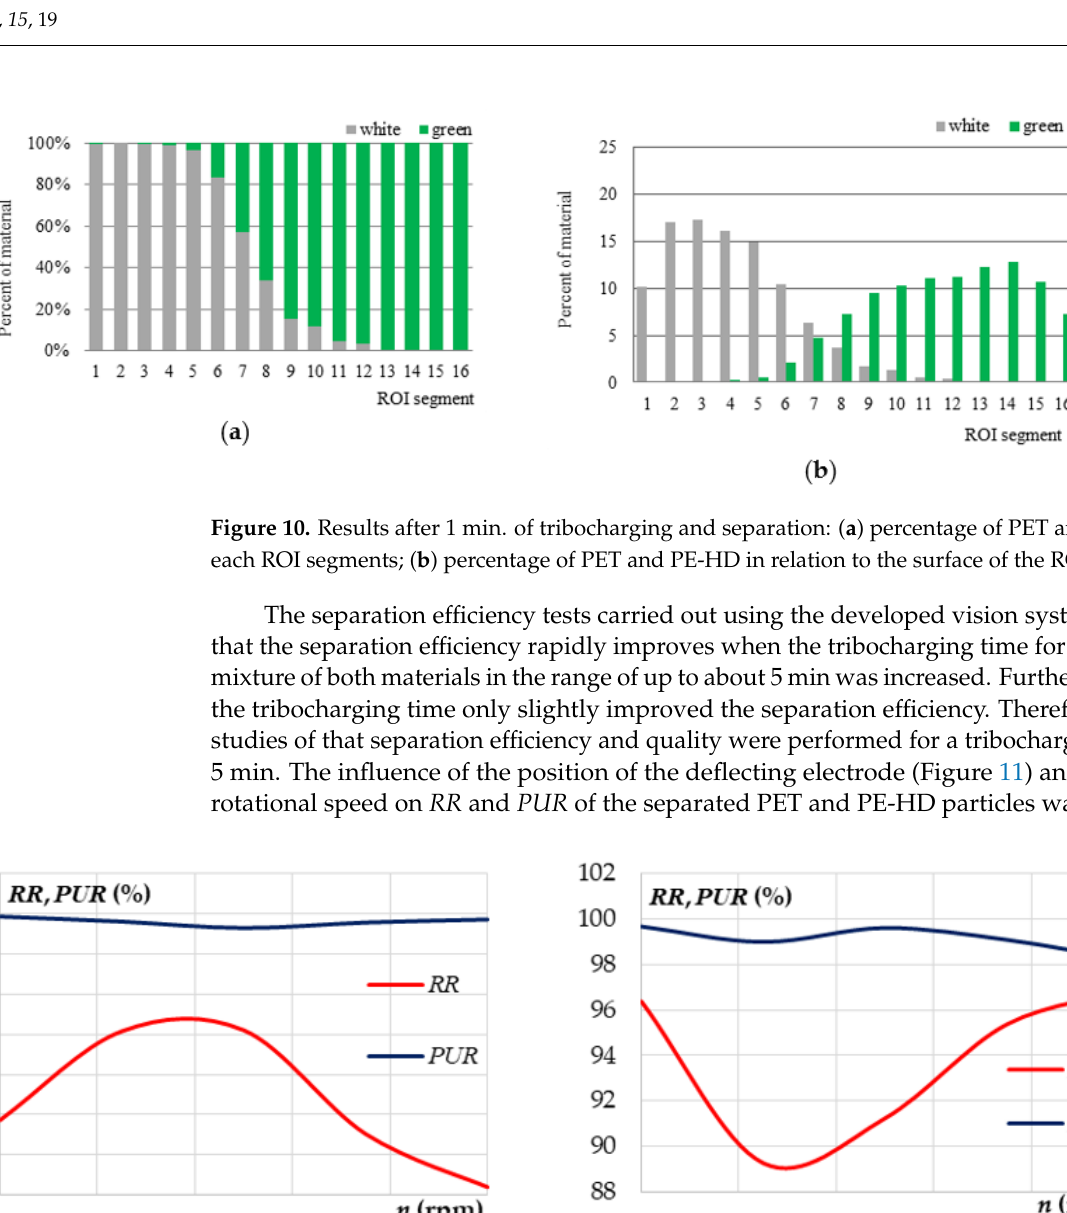
Figure 9. Results after 5 min. of tribocharging and separation: ( a ) percentage of PET and PE-HD in each ROI segments; ( b ) percentage of PET and PE-HD in relation to the surface of the ROI seg- ments.